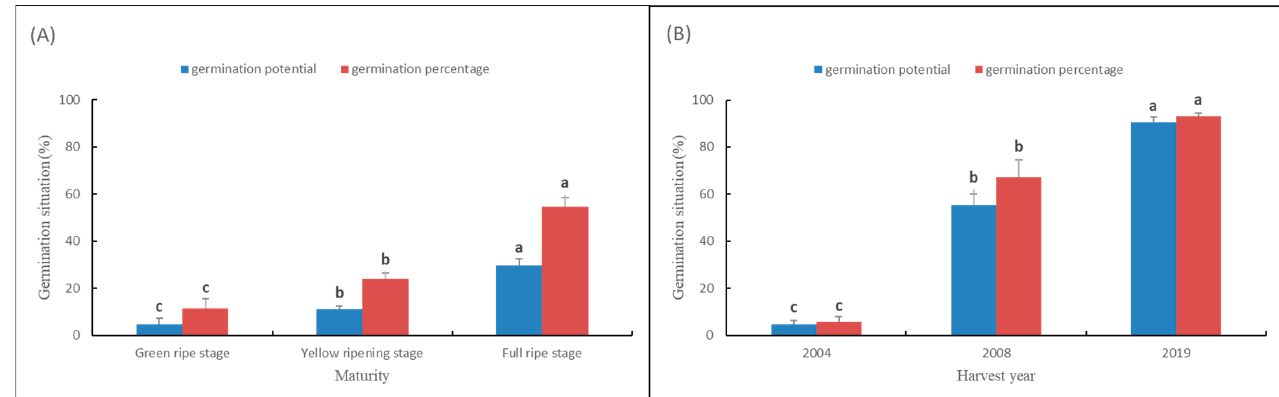
Figure 1. Germination potential and germination percentage of seeds at ( A ) different maturity levels and ( B ) harvest years. Note: Different lowercase letters indicate significant differences ( p < 0.05).